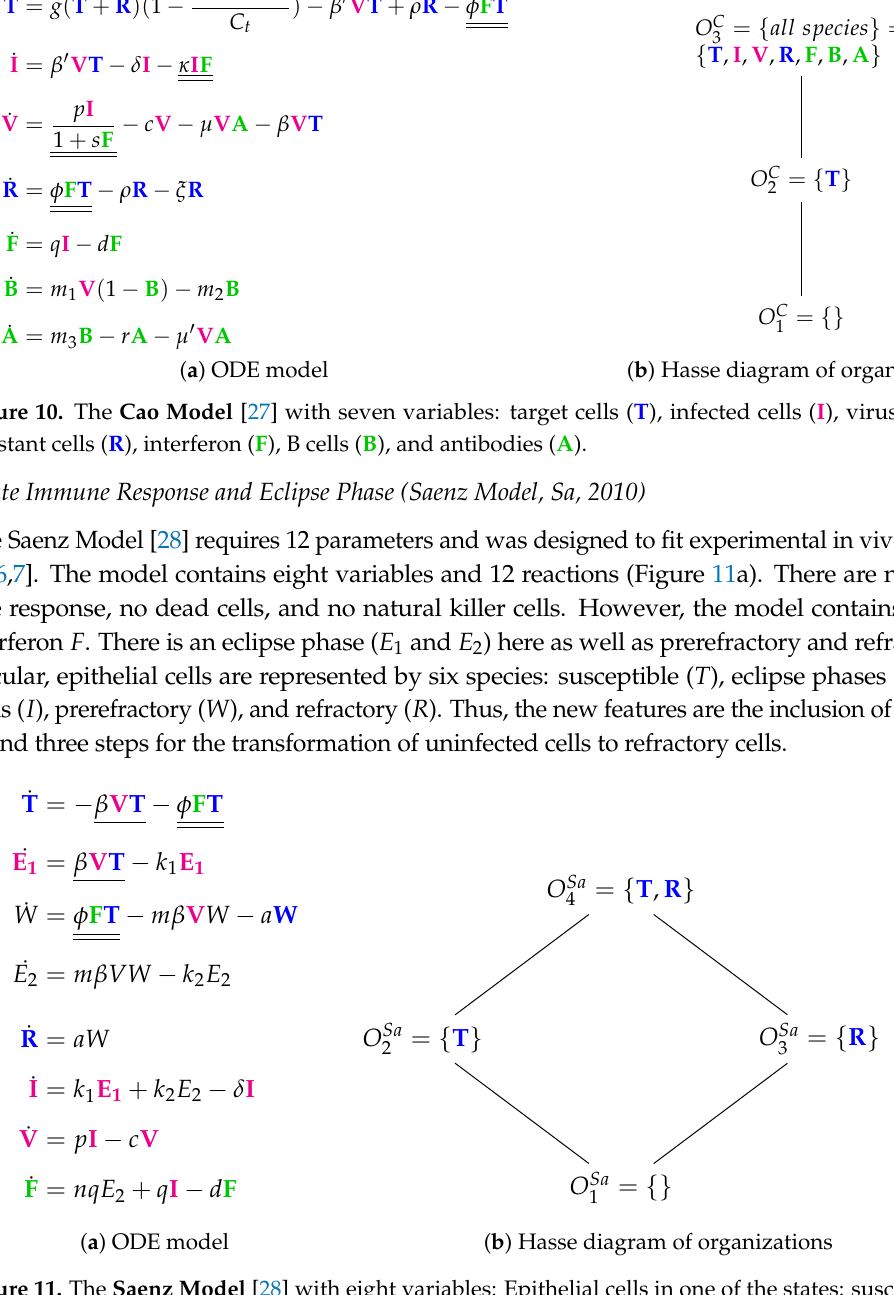
Figure 11. The Saenz Model [28] with eight variables: Epithelial cells in one of the states: susceptible ( T ), eclipse phase ( E 1 and E 2 ), prerefractory ( W ), refractory ( R ) and infectious ( I ). The further variables are: virus cells ( V ) and interferon ( F